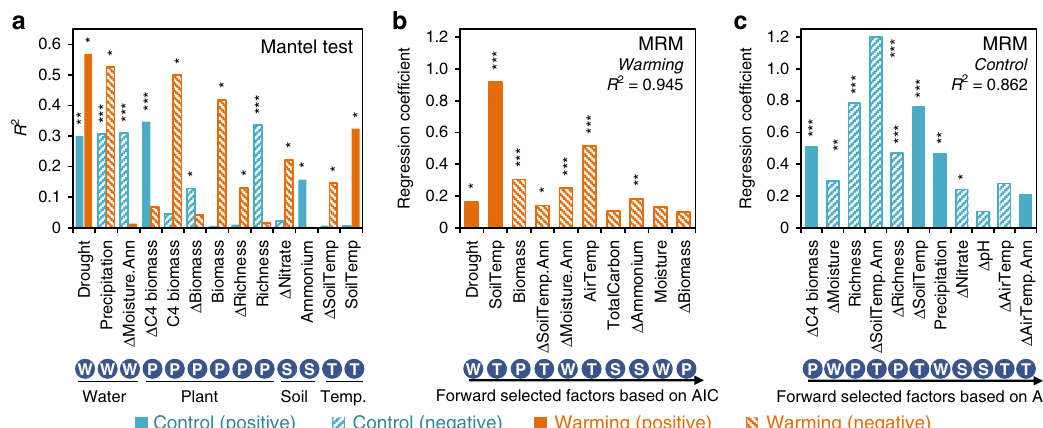
Fig. 5 Effects of environmental factors on homogeneous selection. a Correlations under warming (orange) and control (aqua) based on Mantel test. This fi gure showed only the factors with signi fi cant correlations. See Supplementary Table 2 for other factors. b Multiple Regression on distance Matrix (MRM) under warming. c MRM under control. R 2 , coef fi cient of determination based on the best model from Mantel analysis (see Supplementary Table 2 for details). The correlation was determined based on the difference (with a triangle before the name) or the mean (without triangle) of a factor between each pair of samples. Factors marked with ‘ .Ann ’ are annual means, while the remaining were measured in the sampling month. Livid circle under each factor name indicate the factor related to water (W), plant (P), soil properties (S), or temperature (T). Signi fi cance was expressed as *** p < 0.01; ** p < 0.05; * p < 0.1 (see Source Data fi le for exact p values). Temp, temperature. Source data are provided as a Source Data fi